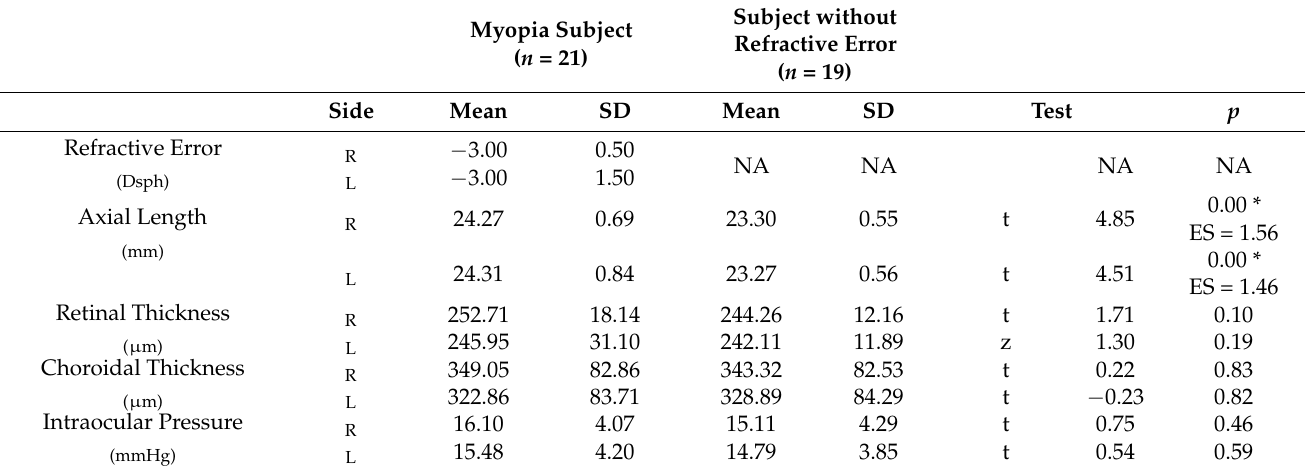
Table 1. Presentation of ophthalmological parameters between the